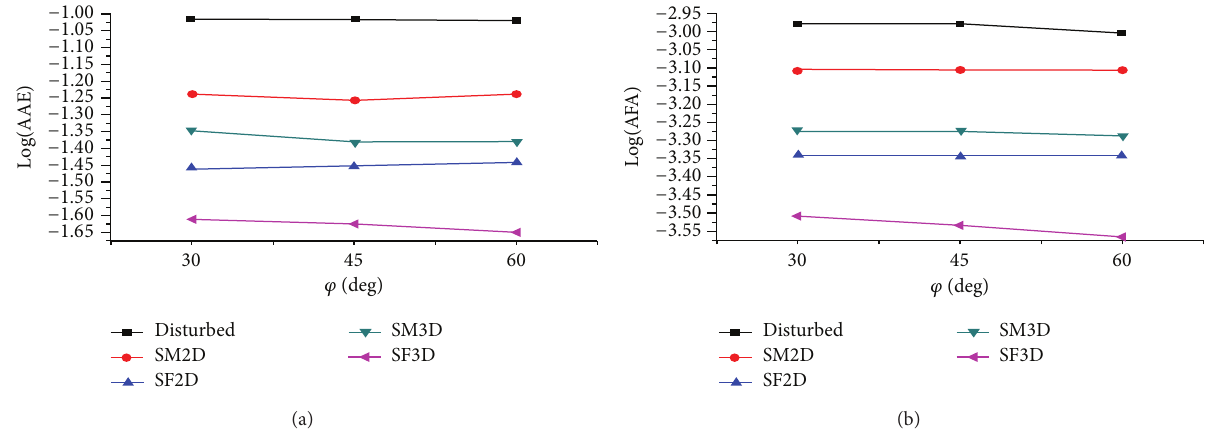
Figure 9: Errors with respect to 𝐴 𝐼 , 𝐴 𝐼𝐼 , and 𝐴 𝐼𝐼𝐼 with 𝜑 = 30 ∘ , 45 ∘ , 60 ∘ , respectively, when we recover the synthetic data with Gaussian noise having mean 0 and 𝜎 = 0.01 using the four median filtering methods: (a) Log (AAE) error and (b) Log (AFA)